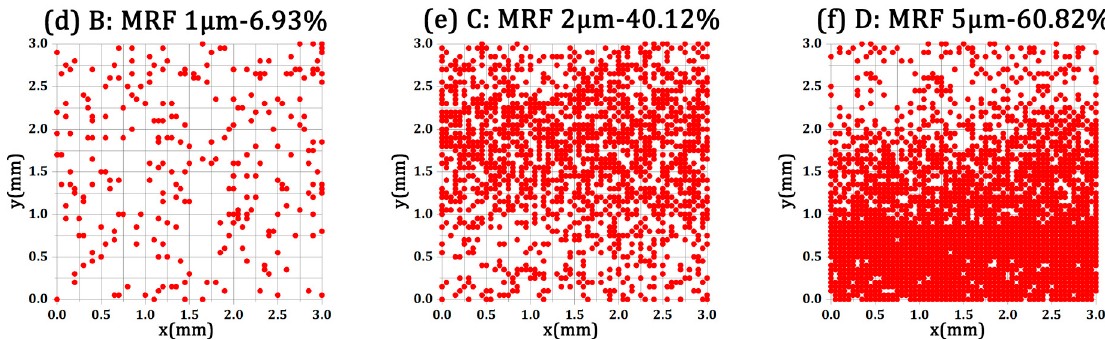
Figure 9. Distribution characters of the defects with the absorption over 2 ppm on the surfaces of the polished and post-treated fused silica samples. The density of the corresponding defects on the surface for each sample is given.